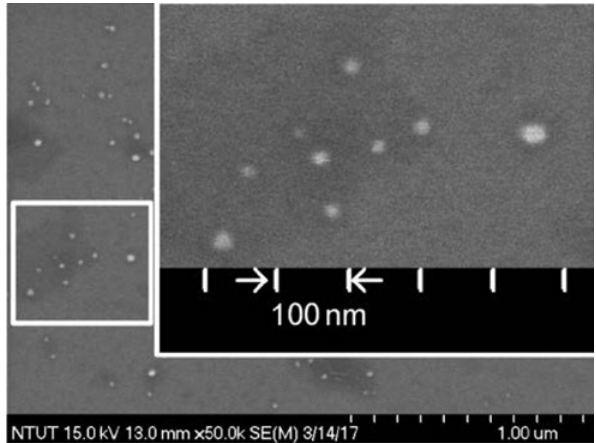
Figure 7: An SEM diagram of Ag